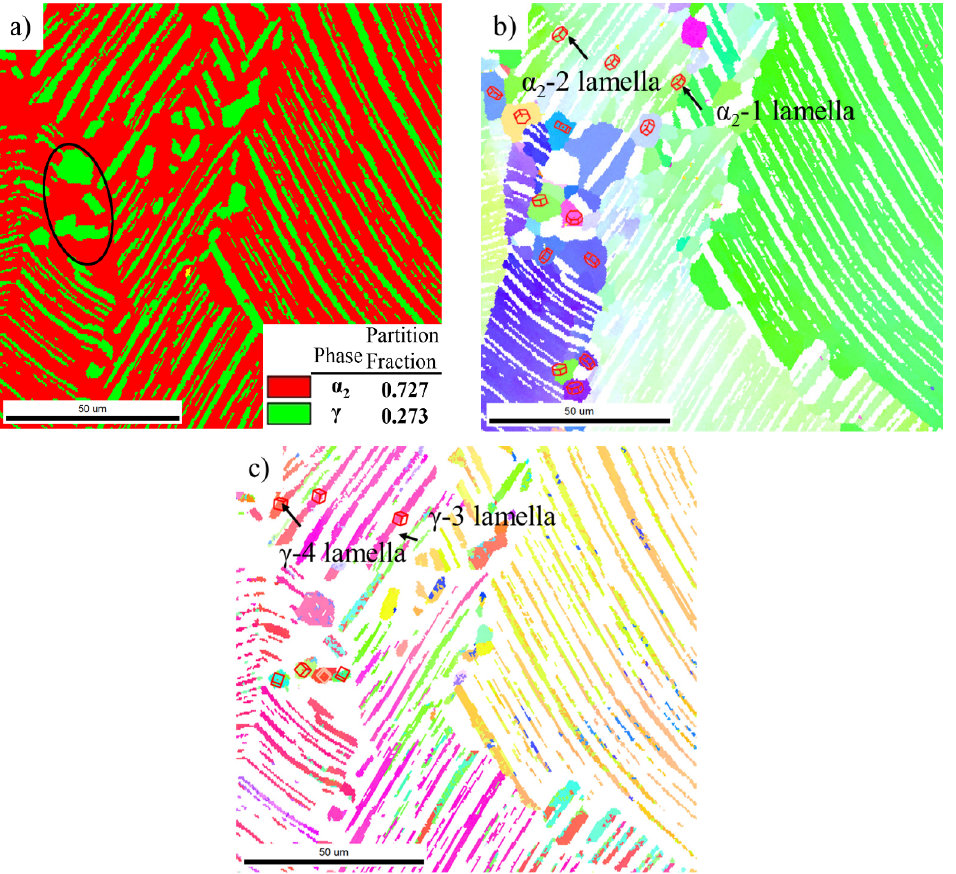
Figure 2. EBSD analysis of water quenched Ti-44Al-8Nb-(W, B, Y) alloy after annealing at 1250 °C for 2 h: ( a ) phase map, orientation maps of ( b ) α 2 phase and ( c ) γ phase.